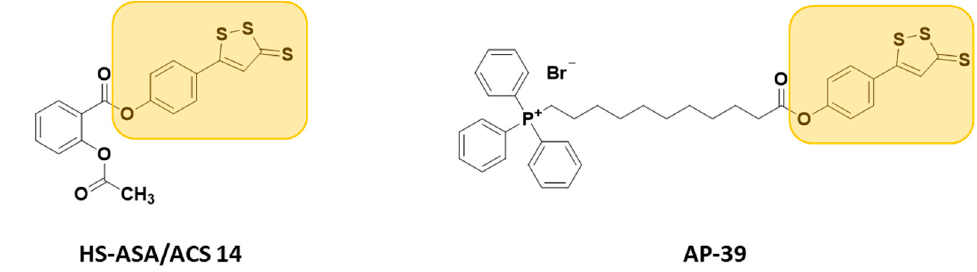
Figure 7. Chemical structures of H 2 S donor hybrids involved in cardiovascular